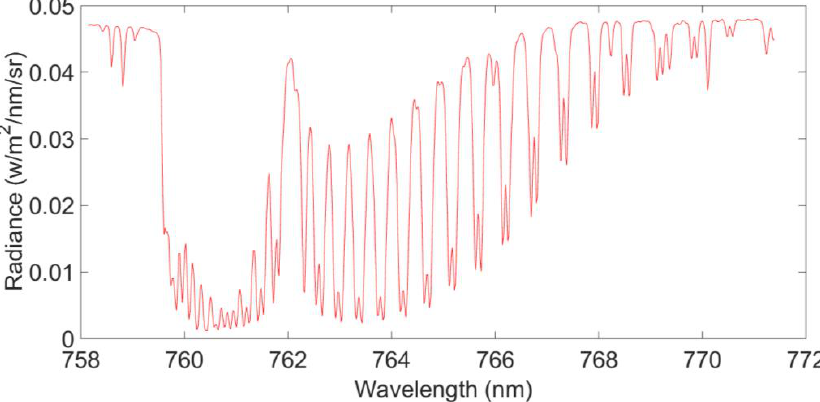
Figure 1. Band 1’s flight test observational L1B data: spectral radiance in 760 nm.